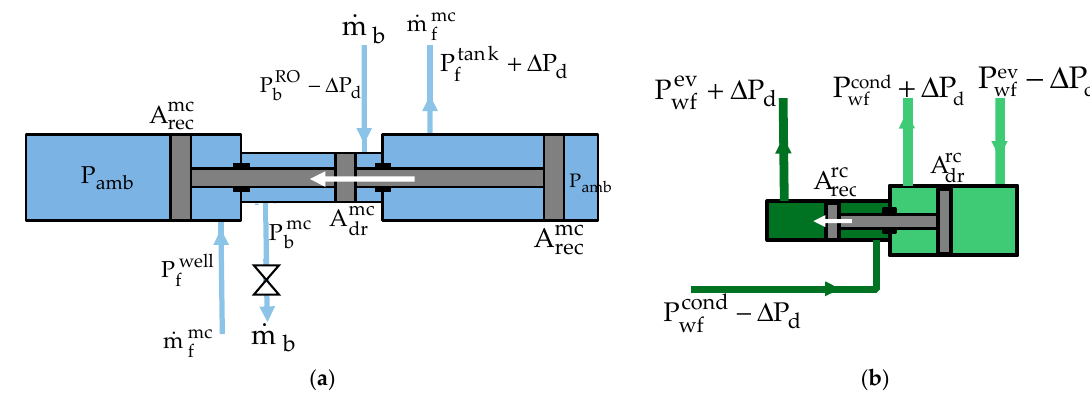
Figure 7. Modeling of hydraulic cylinders: ( a ) main cylinder, ( b ) refilling cylinder.